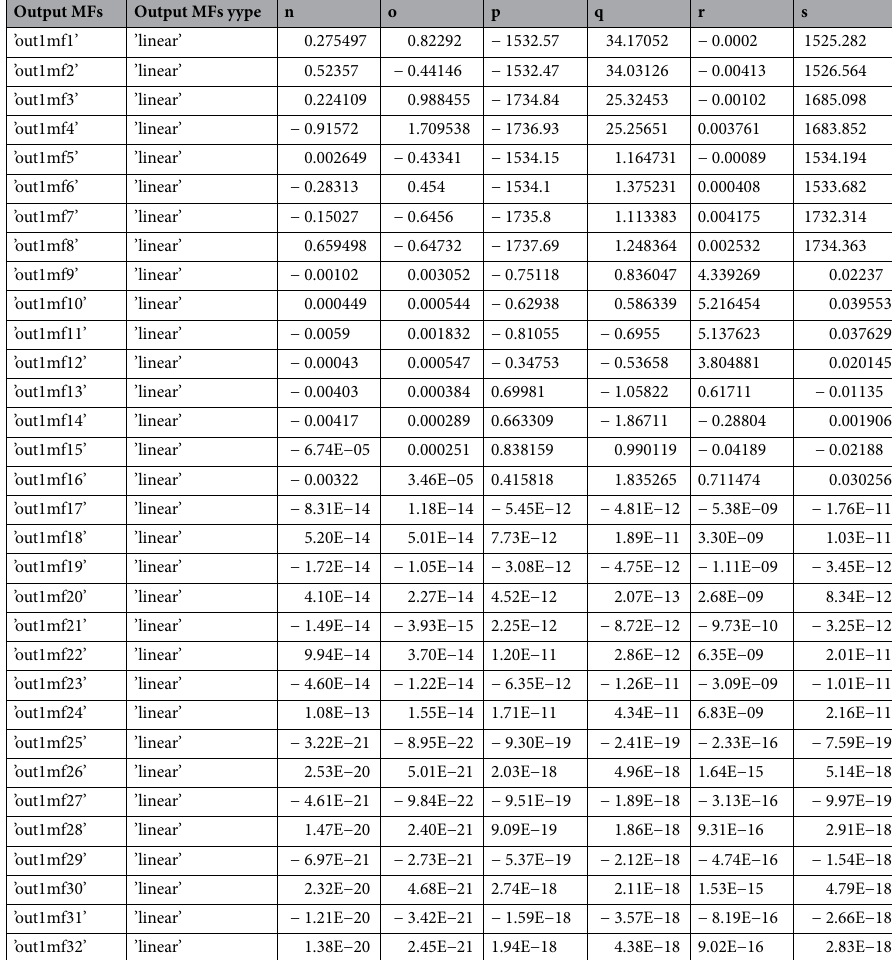
Table 6. The consequent parameters of ANFIS for prediction of the pressure.